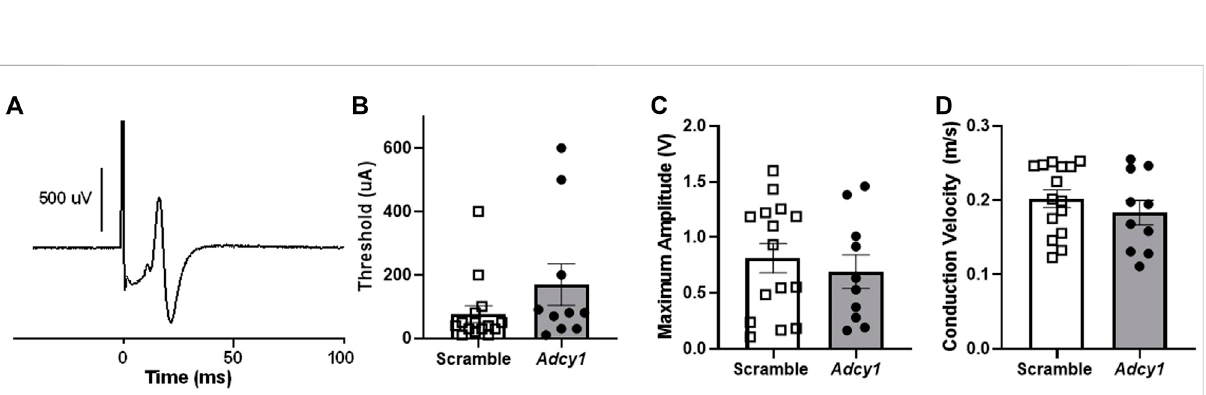
FIGURE 7 Intrathecal administration of AAV9-GFP-U6-m- Adcy1 -shRNA ( C ) or AAV9-GFP-U6-scramble-shRNA ( □ ) does not alter sciatic nerve C- fi ber conduction properties. (A) Example of a compound action potential (CAP) recording from sciatic nerve of mouse. The (B) electrical thresholds, (C) maximum CAP amplitude, and (D) conduction velocity, were not signi fi cantly different between groups. Data presented as mean ± SEM with n = 10 –